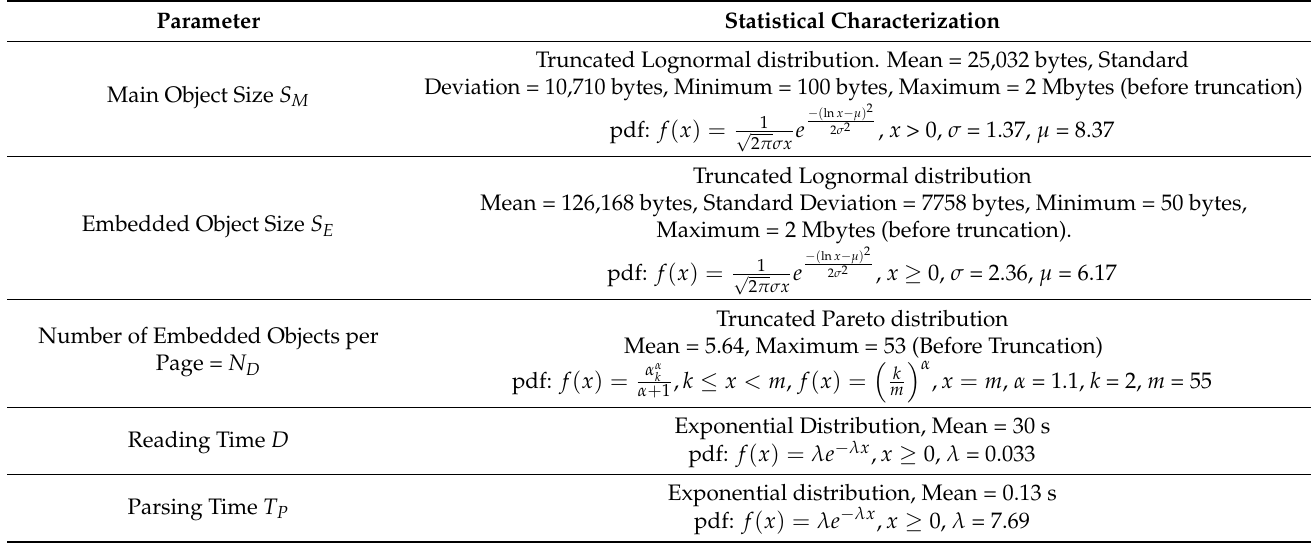
Table A2. Web-browsing traffic